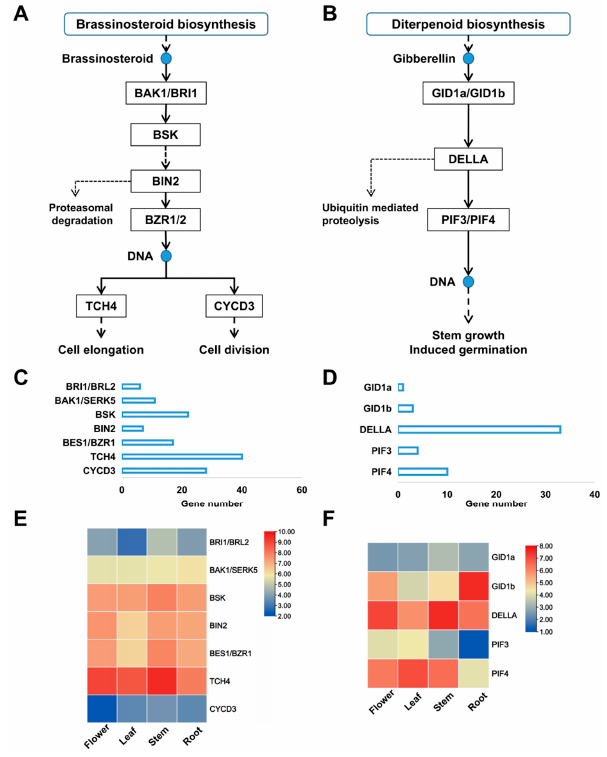
Figure 4. The candidate genes in potato brassinolide and gibberellin pathways. ( A ) potato-brassino- lide pathway. ( B ) potato gibberellin pathway. ( C , D ) The copy number of candidate genes in potato brassinolide ( C ) and gibberellin ( D ) pathways. ( E , F ) Expression profiles of associated, differentially expressed candidate genes among different tissues in potatoes.